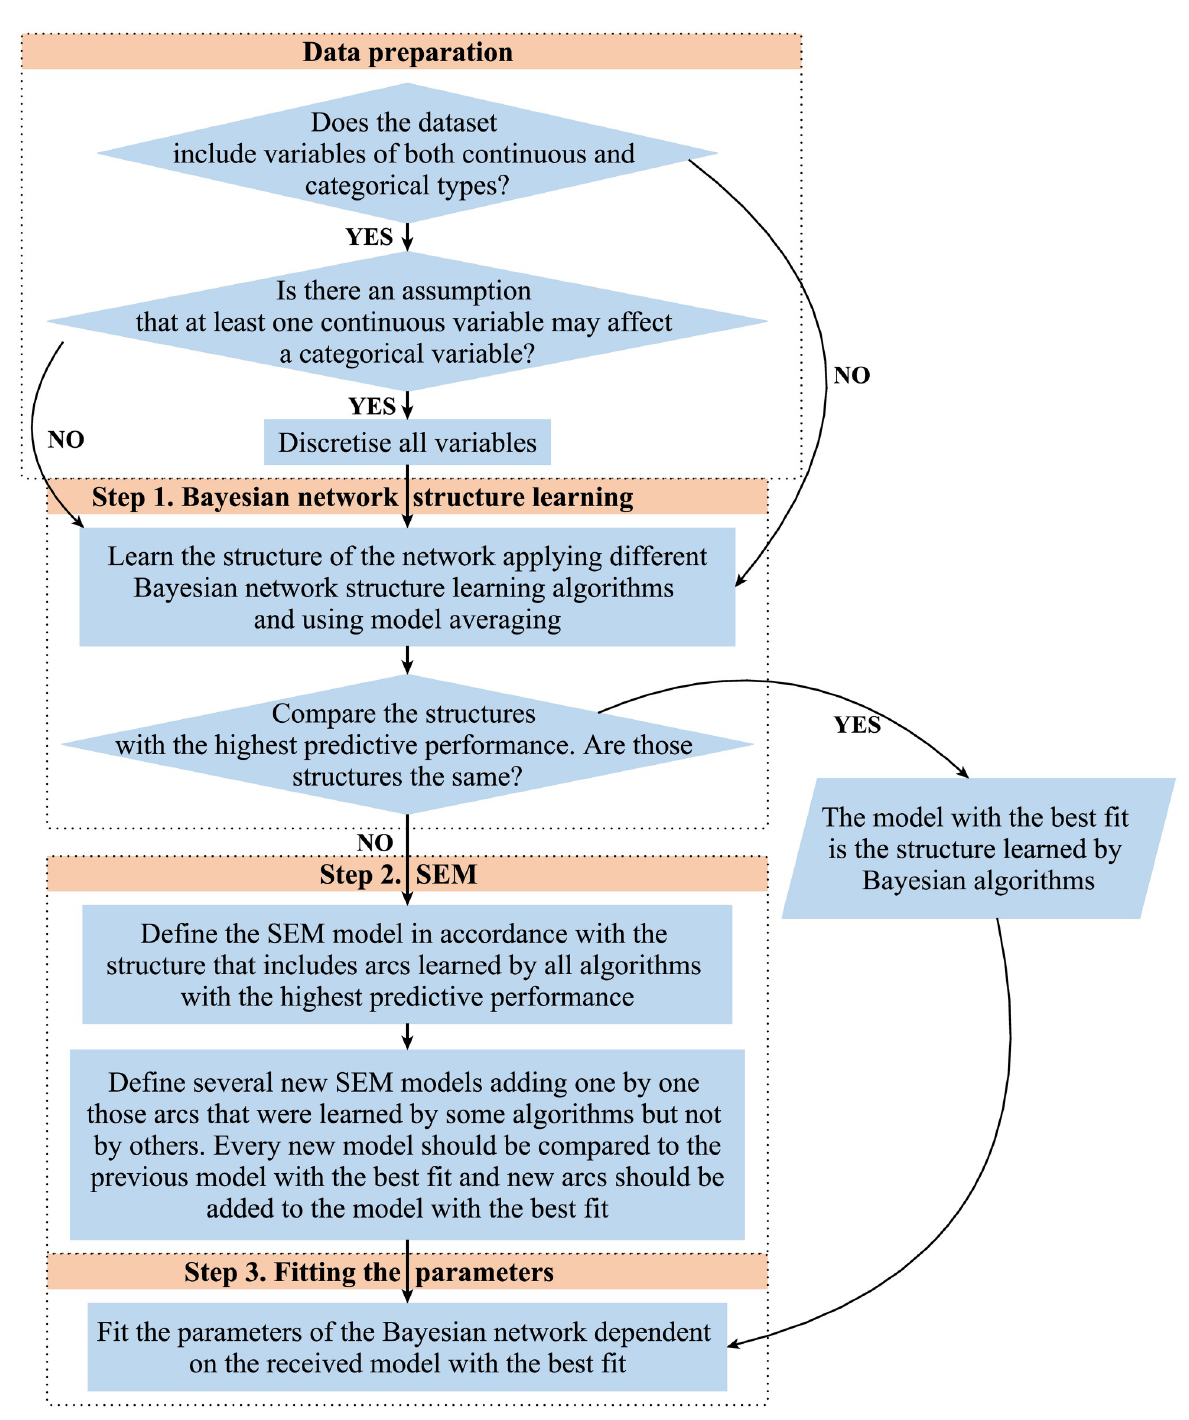
Fig 1. The step-wise description of the procedure in analysing the data.